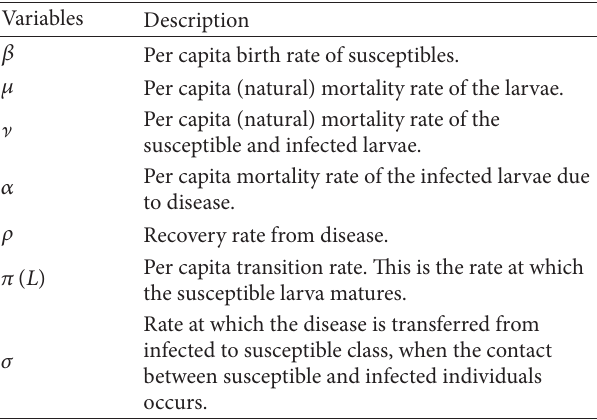
Table 1: Description of parameters in model